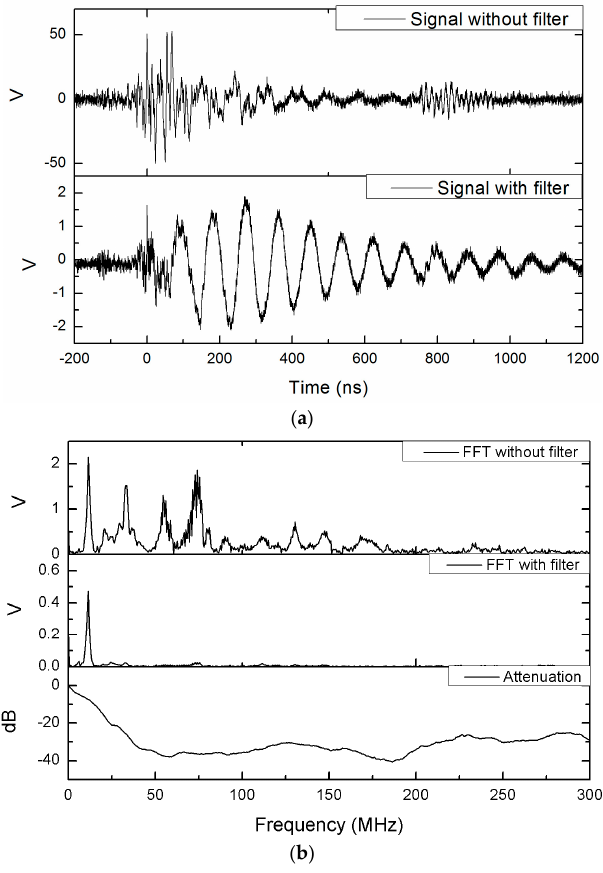
Figure 11. Signal obtained with the application of the protection system: ( a ) EMN signal acquired at the controller cable when is connected directly to the pump, compared with the measured signal while passing through the filtering system; ( b ) FFT plots showing the attenuation of EMN signal for frequencies above 25 MHz. The overall attenuation of the filter system is shown with respect to the frequency.